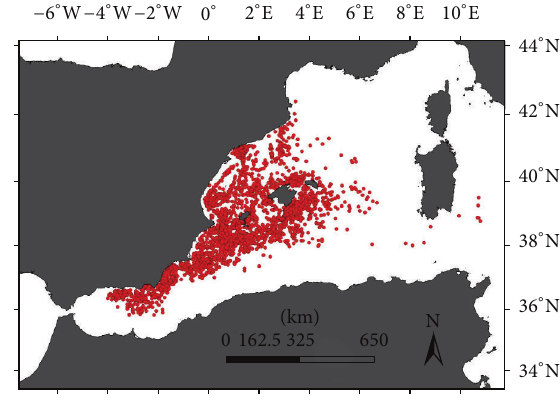
Figure 1: Fisheries effort distributions of Spanish surface longline fleet for entire study